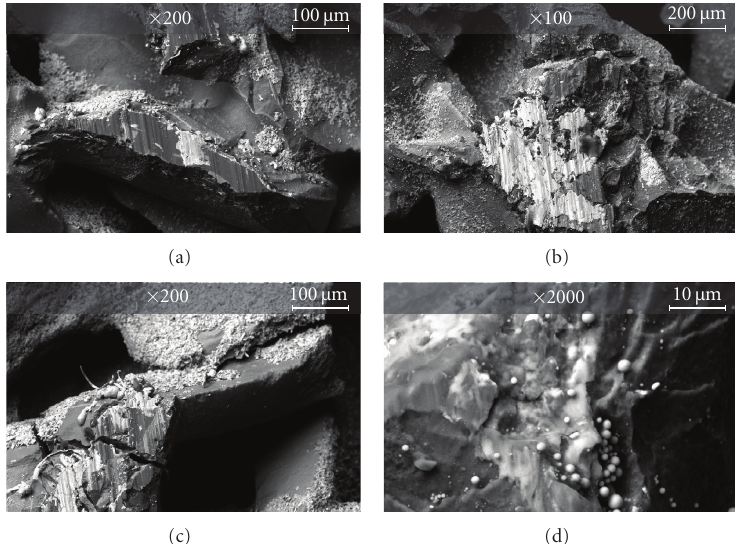
Figure 8: Microscopic view of the GWAS after grinding: (a) wear land of SG abrasive grain; (b) smear of workpiece chips on the abrasive grain vertex; (c) crack of the vitrified bond bridge; (d) spherical chips of machined material on the abrasive grain vertex.